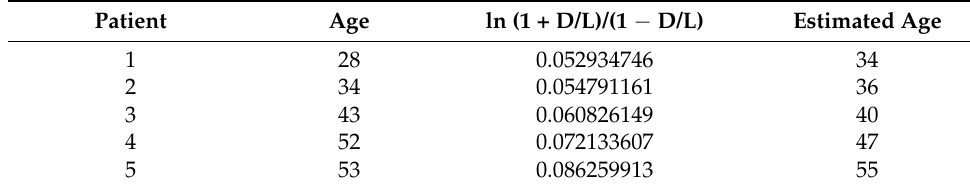
Table 3. Aspartic acid racemization rates with respect to the chronological age in the validation set. Age was estimated based on these racemization rates and the regression formula.